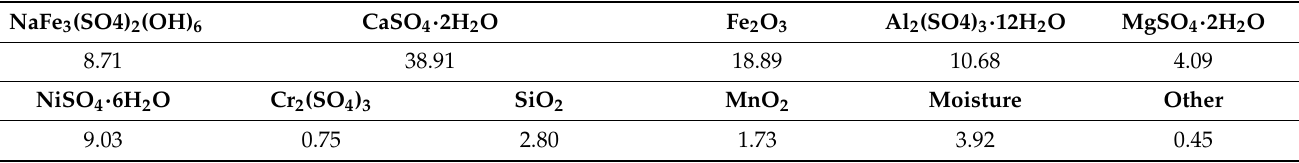
Table 1. Mineralogical composition of natrojarosite residue (in